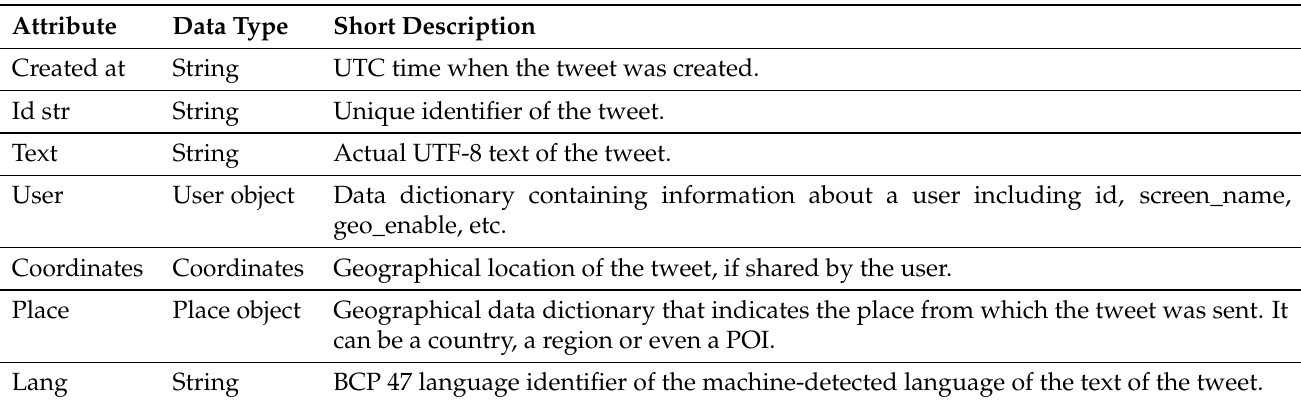
Table 1. Tweet attributes in Twitter